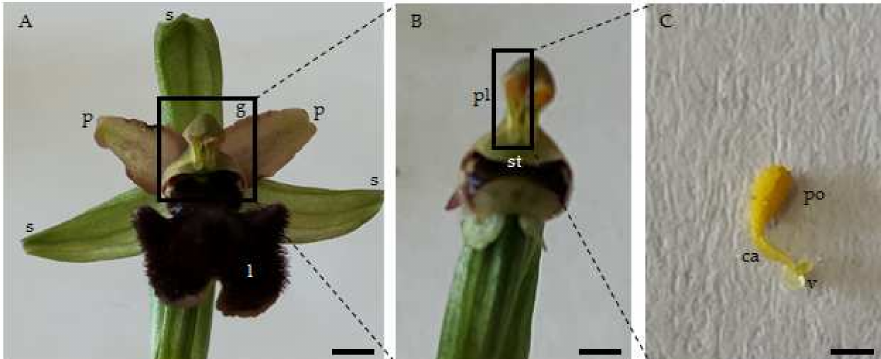
Figure 1. Flower ( A ), column ( B ) and pollinarium ( C ) of an orchid. P = petal, s = sepal, l = labellum, c = column, st = stigma, pl = pollinarium, po = pollinium, ca = caudicle, v = viscidium. Scale bar: 1 cm.